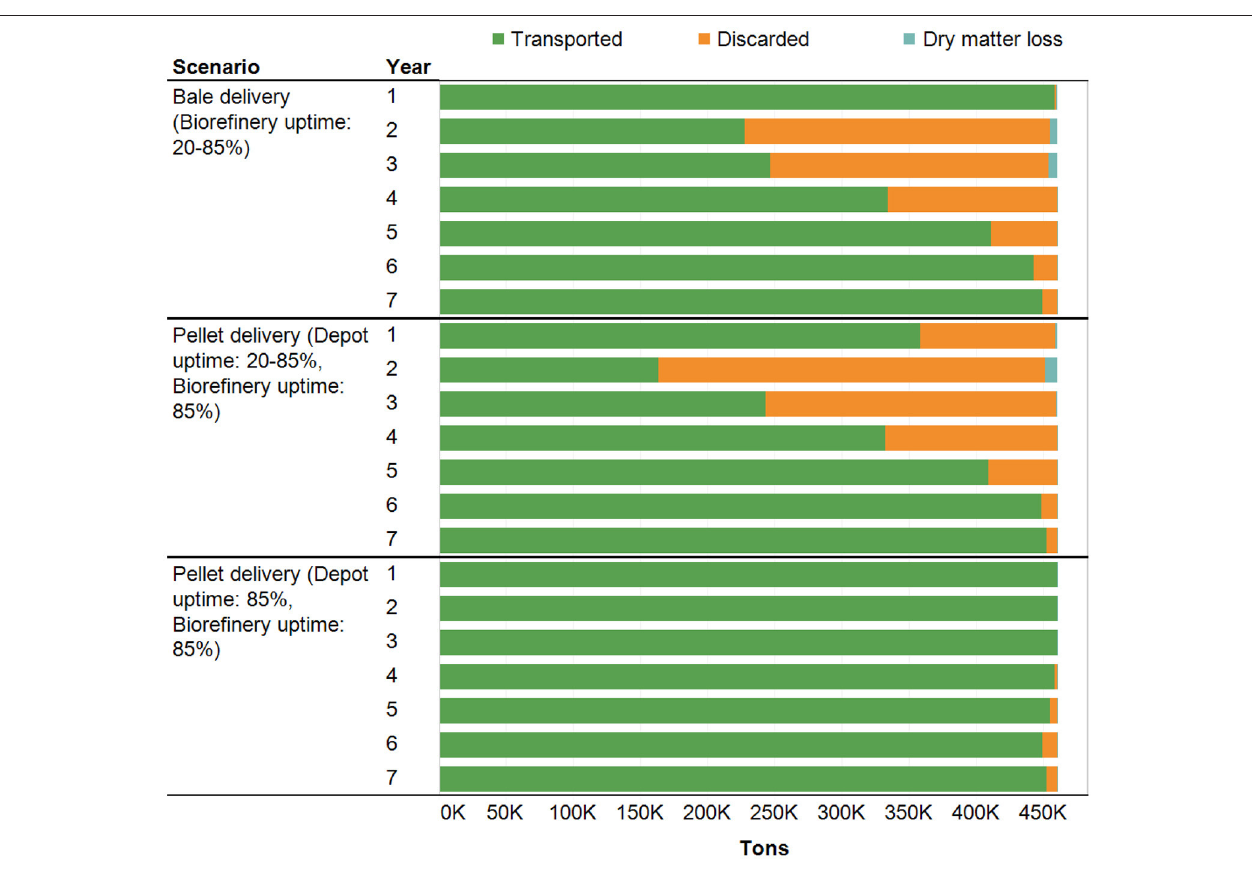
(A) the processing facility should have higher uptime; (B) fewer farms should be contracted at the beginning, and the number subsequently increased as uptime increases; (C) determining alternative corn stover